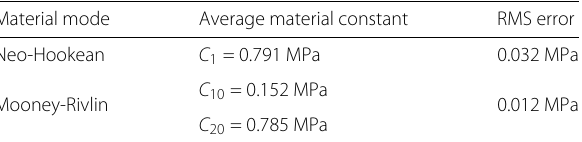
Table 3 RMS errors for uni-axial material testing Material